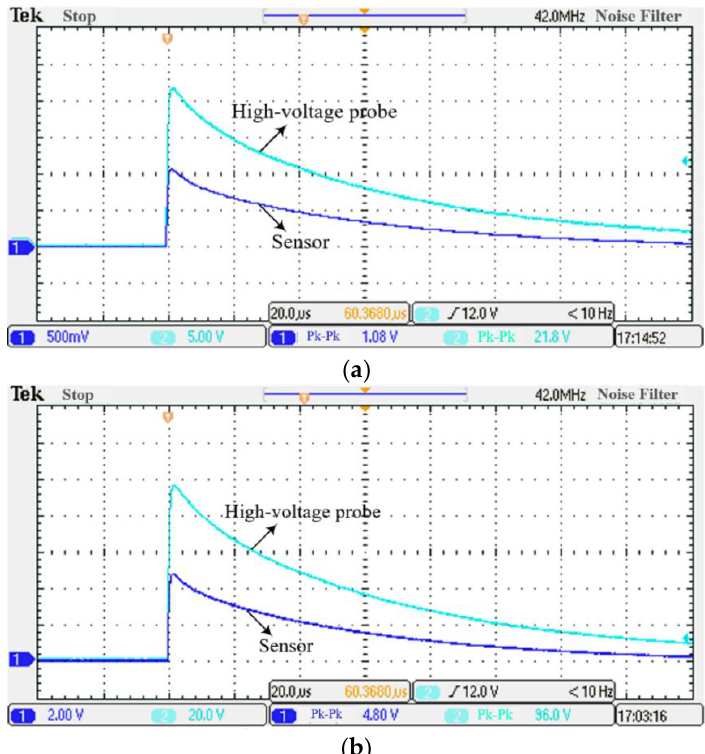
Figure 13. Transient measurement waveform of the Dual-Differential D-dot overvoltage sensor; ( a ) 2 kV, ( b ) 9 kV. Table 4. Test results of transient